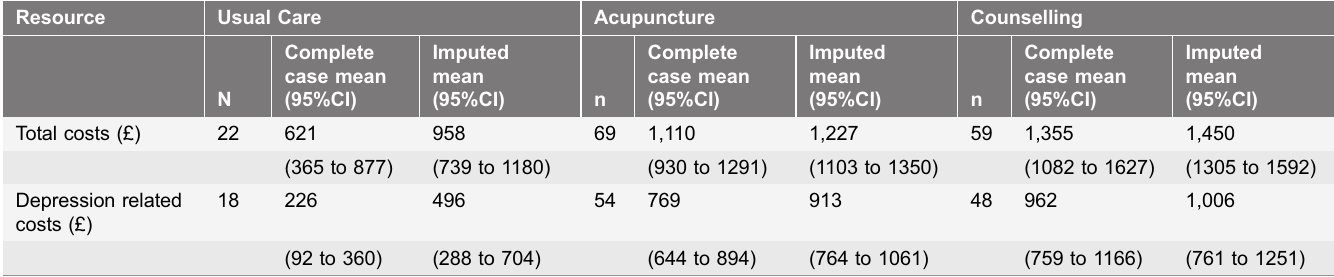
Table 3. Complete case and imputed costs over 12 months.